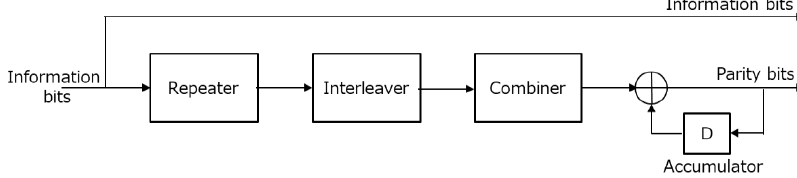
Figure 3. Structure of systematic repeat-accumulate (RA) code encoder.